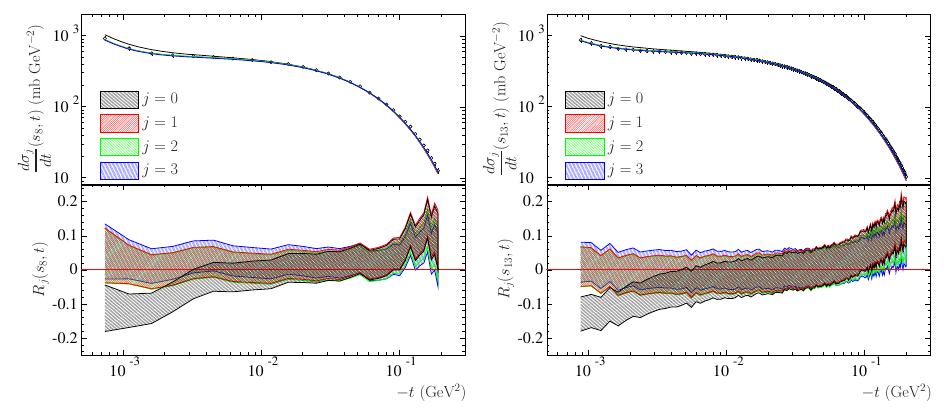
t region, at √ s = 8 and 13 TeV, in left −